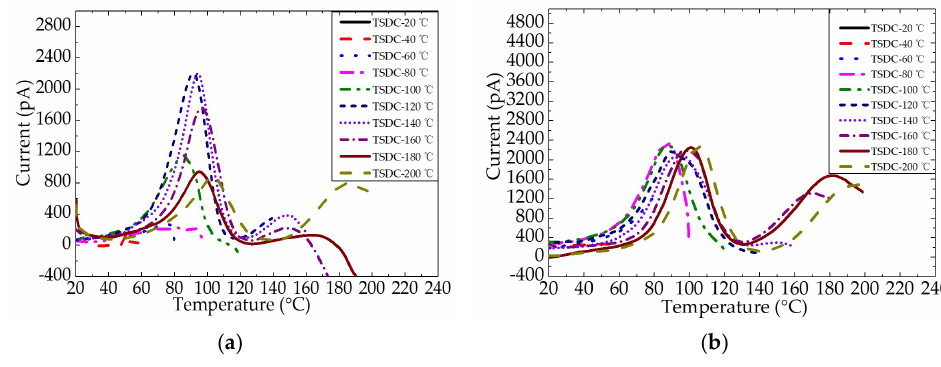
Figure 11. TSDC of epoxy resin ( a ) and epoxy/nano−SiO 2 /micro−BN composite ( b ).